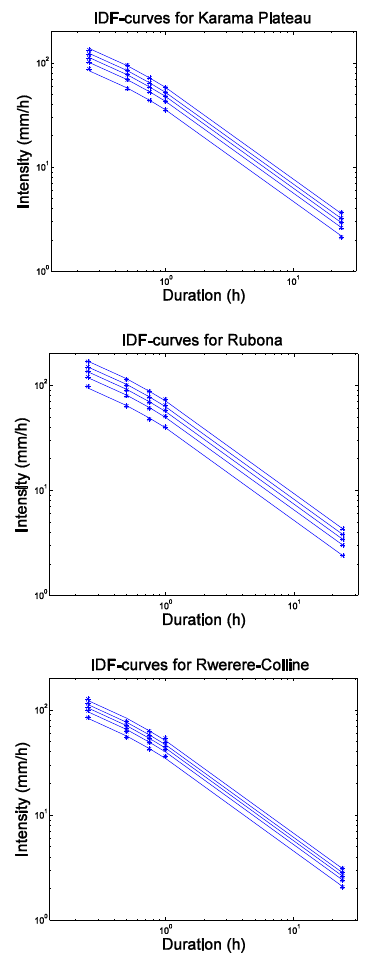
Figures 3 a, b & c: Intensity-Duration-Frequency (IDF) curves for precipitation at the 8 Fig. 3. Intensity-Duration-Frequency (IDF) curves for precipitation stations (from top to bottom) Karama-Plateau, Rubona and Rwerere-Colline, Rwanda, 9 at the stations (from top to bottom) Karama-Plateau, Rubona and using A-type statistical parameters values produced by the van Montfort technique. 10 Rwerere-Colline, Rwanda, using A-type statistical parameters val- ues produced by the van Montfort